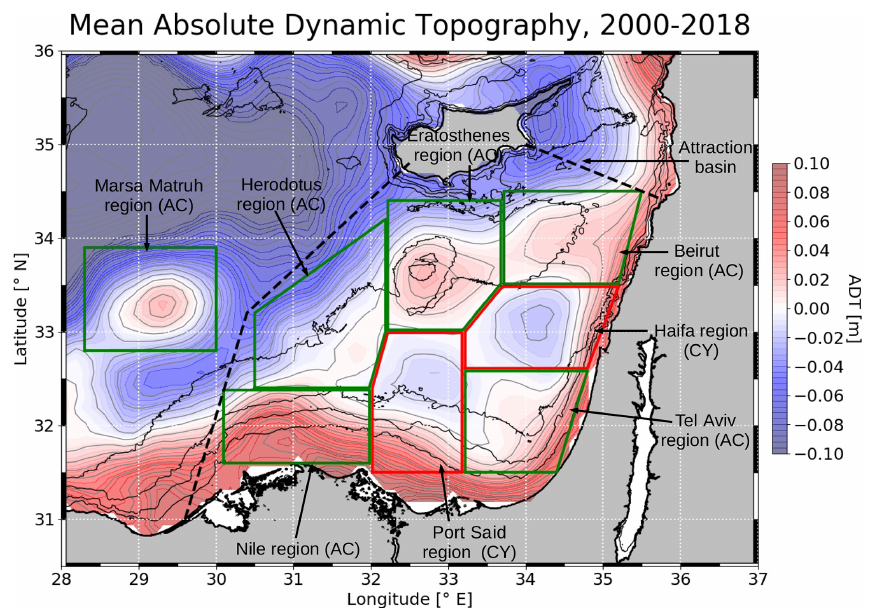
Figure 3. Mean dynamic topography (MDT) map of the southeastern LB labeled with borders and names of the study regions. Anticyclonic regions (AC) have a green border, cyclonic regions (CY) have a red border, and boxes are based on the coordinates indicated in the Appendix (Table A1). The black dashed line is the attraction basin introduced in Sect.